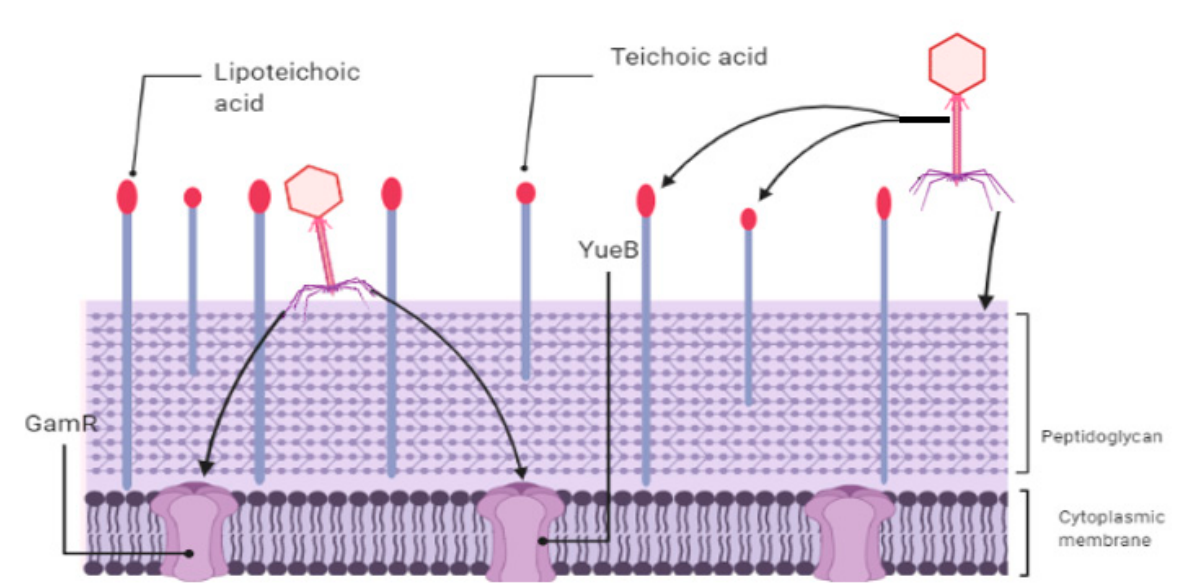
Figure 3. Target receptors of Gram-Positive bacteria for phage adsorption including peptidoglycan, lipoteichoic acid, teichoic acid, and integral proteins in cytoplasmic membrane.